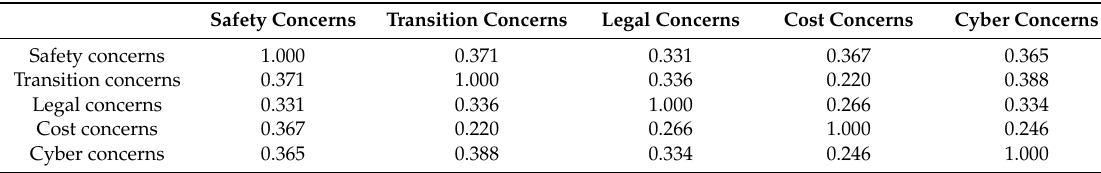
Table 8. Inter-item correlation matrix;